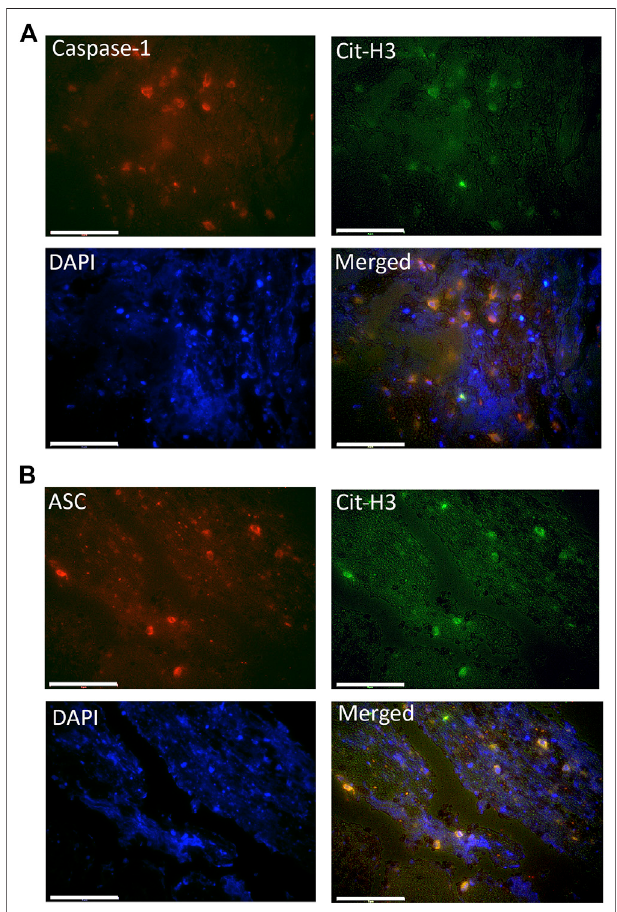
FIGURE 3 | Caspase-1 and ASC are present within citrullinated-H3 structures. Fluorescent images of the clots of patients that were double- stainedforCit-H3(green)and (A) caspase-1(red)or (B) ASC(red).Caspase-1 and ASC positive cells were also immunorective for Cit-H3 (yellow) and nuclei were stained with DAPI (blue). Magni fi cation: 60X. Scale bar: 75 μ m.